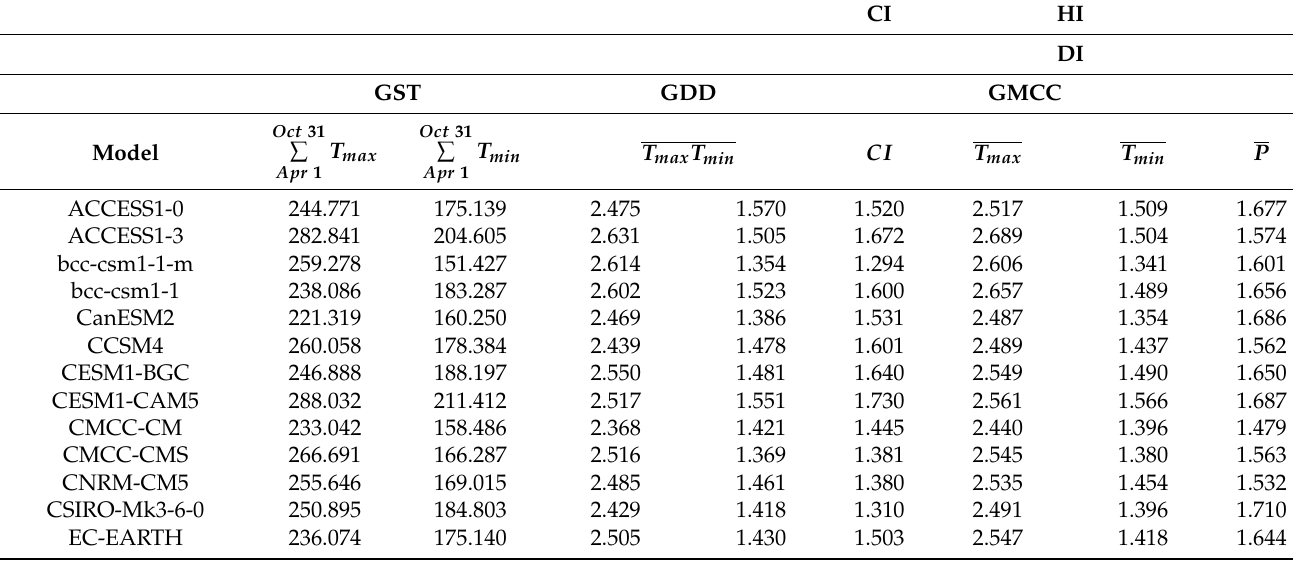
Table 3. Localized Constructed Analogs (LOCA) Coupled Model Intercomparison Project phase 5 (CMIP5) [40,41] model root mean squared error (RMSE) values by variable, as defined in Table 2, for calculation of the growing season average temperature (GST), growing degree days (GDD), Huglin index (HI), cool night index (CI), dryness index (DI), and the G é oviticulture multicriteria climate classification (GMCC) throughout the Willamette Valley American Viticultural Area during the LOCA CMIP5 defined historic period